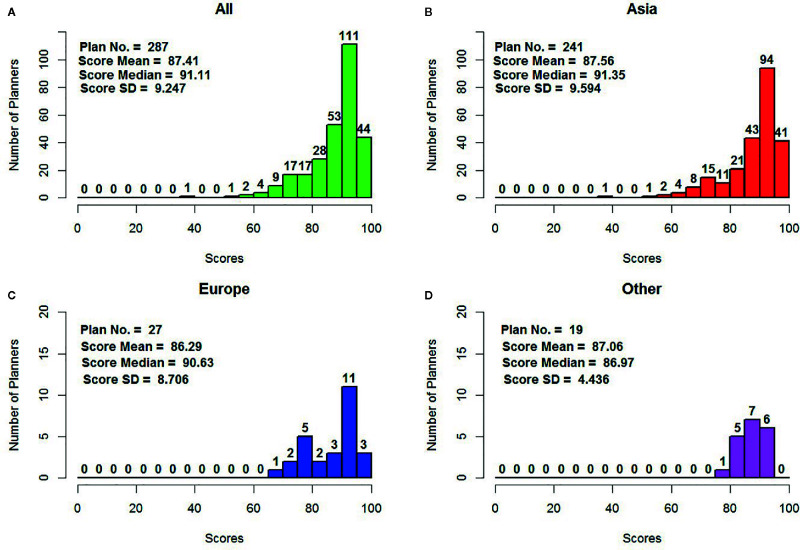
Plan score distribution by continent and overall (A) overall (B) for Asia (C) for Europe, and (D) for other continents including North America, South America, and Oceania.